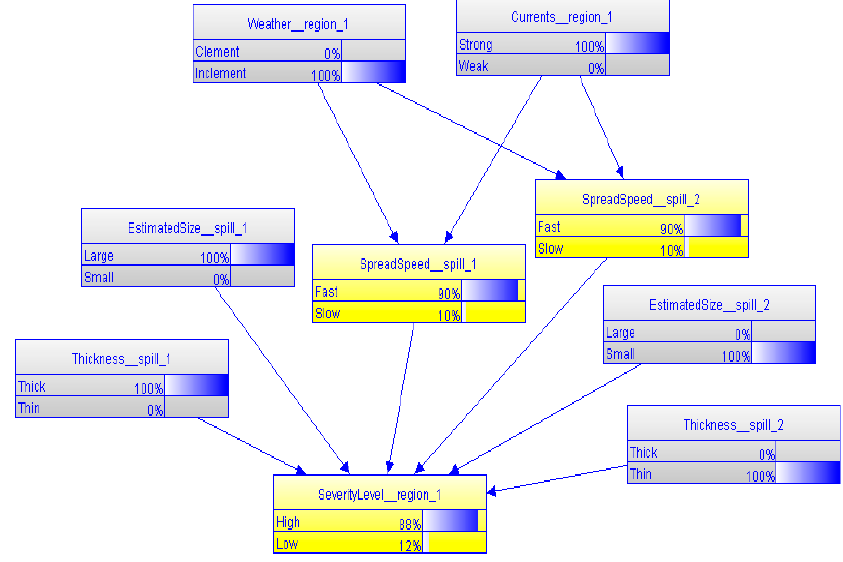
Figure 10. Situation-Specific Bayesian Network (SSBN) generated for the scenario with complete findings.